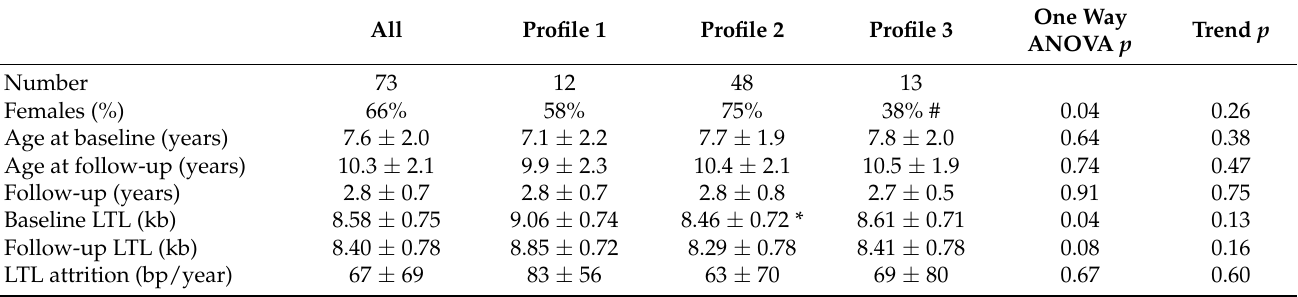
Table 1. Characteristics of the participants according to BMI